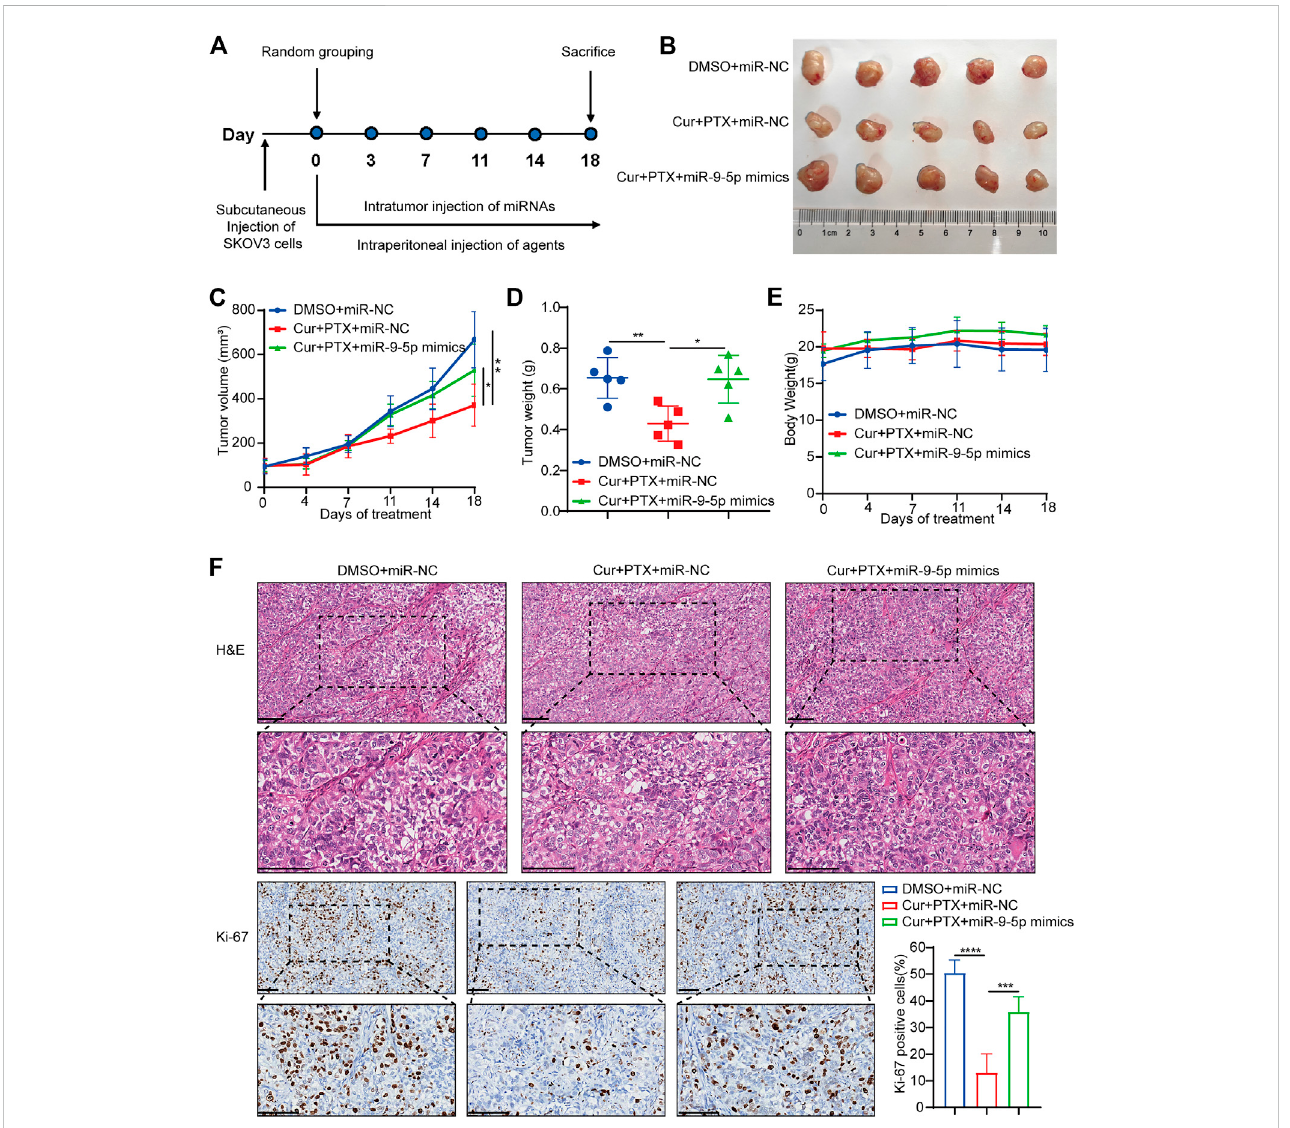
FIGURE 4 Overexpression of miR-9-5pcounteracts thesynergy between Curand PTX in vivo . (A) Mice bearing SKOV3 xenografts weretreated intratumorallywith 50 nmol/kg miR-NC or miR-9-5p mimics, and combined treated with DMSO, or Cur and PTX combination. DMSO, Cur and PTX were administrated as mentioned above ( n = 5 mice per group). (B) Images of tumors collected from mice treated with indicated agents. (C,D) Tumor volume and weight in the xenografts treated with different agents. (E) Mice weight growth curves after indicated treatments at different time points. (F) Representative images of H&E staining and IHC staining of Ki67 for xenograft tumor tissues after indicated treatments. Boxed regions were magni fi ed and presented under the respective panels. Scale bar, 100 μ m. Data are presented as the mean ± SD from fi ve independent repeats. * p < .05, ** p < .01, *** p < .001, **** p <